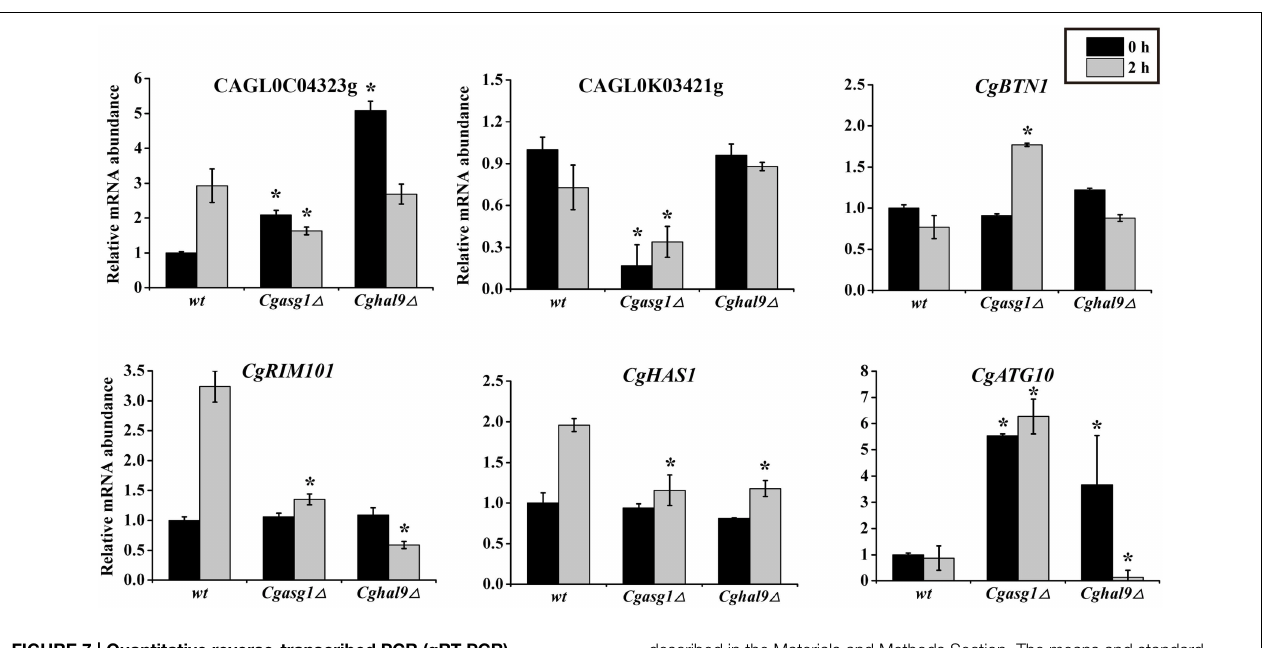
described in the Materials and Methods Section. The means and standard deviations for three independent experiments are shown. C. glabrata strains: wild-type, Cgasg1 1 and Cghal9 1 strains. ( * P < 0 . 05 compared to the corresponding wild-type control, as determined by t